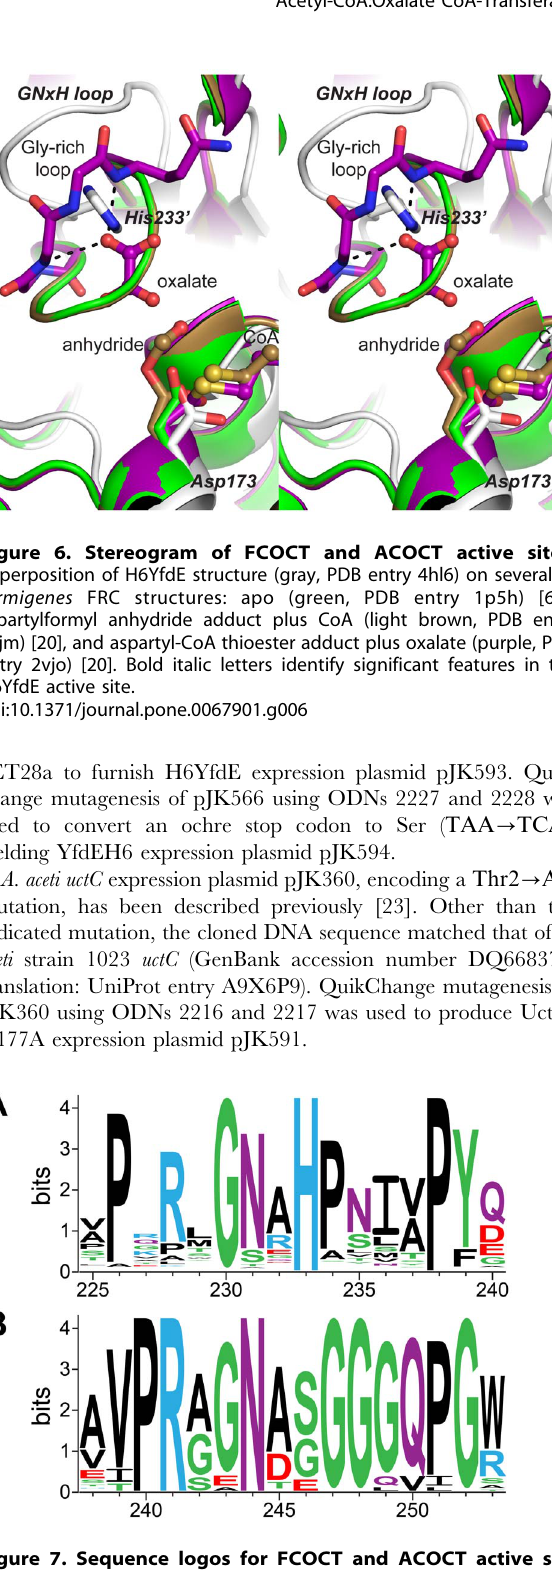
Figure 7. Sequence logos for FCOCT and ACOCT active site loops. (A) Sequence logo for the GNxH loop region in 1116 bacterial homologues of yfdE . The height of each residue code corresponds to the degree of conservation at the indicated position. YfdE sequence numbers are given at the bottom. (B) Sequence logo for the glycine-rich loop region in 182 bacterial homologues of yfdW . The height of each residue code corresponds to the degree of conservation at the indicated position. YfdW sequence numbers are given at the bottom.